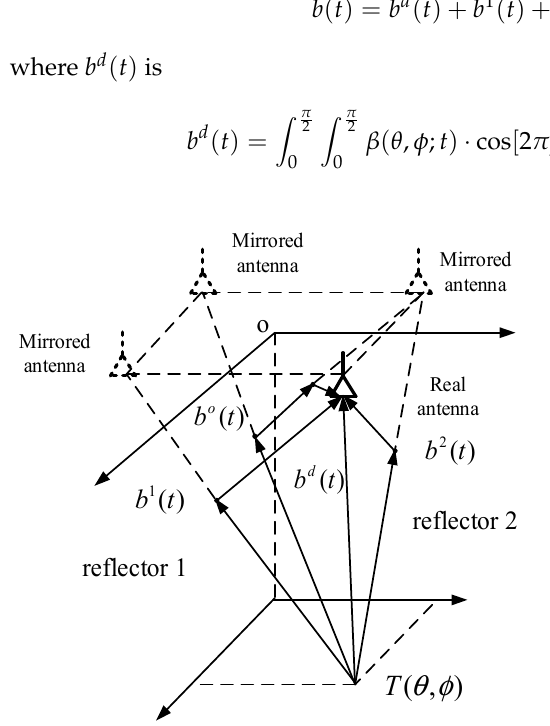
Figure 3. Signal propagation of 2-D MAS.